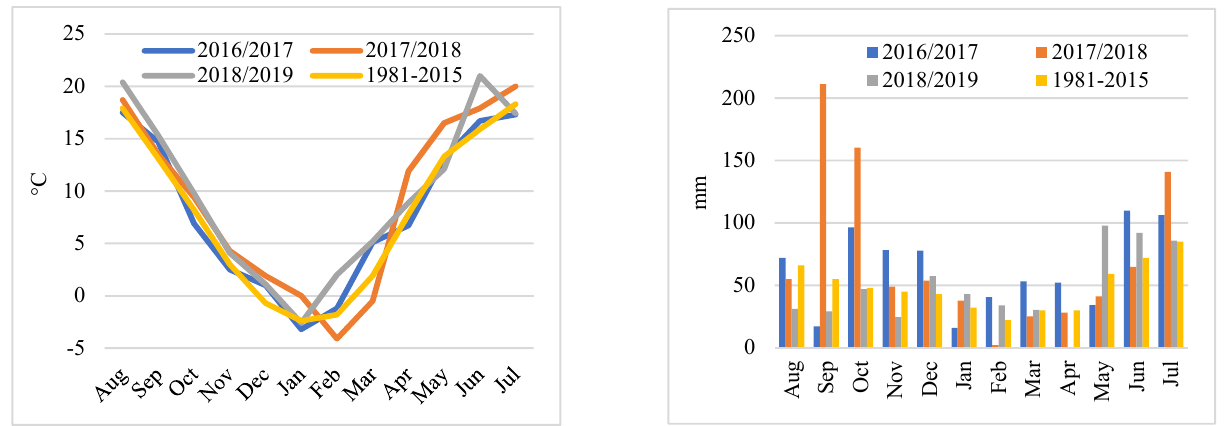
Figure 1. Mean monthly temperature (°C) and total monthly precipitation (mm) during the growing seasons of 2016–2019 vs. the long-term average (1981–2015).